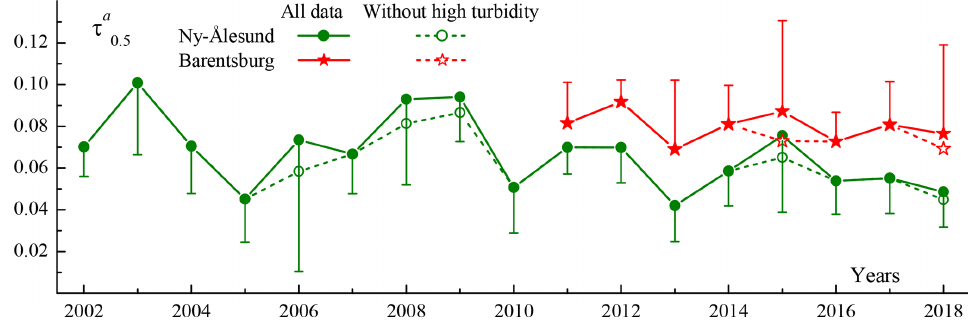
Figure 6. Multiyear variations in the annual AOD in Ny-Ålesund and Barentsburg.